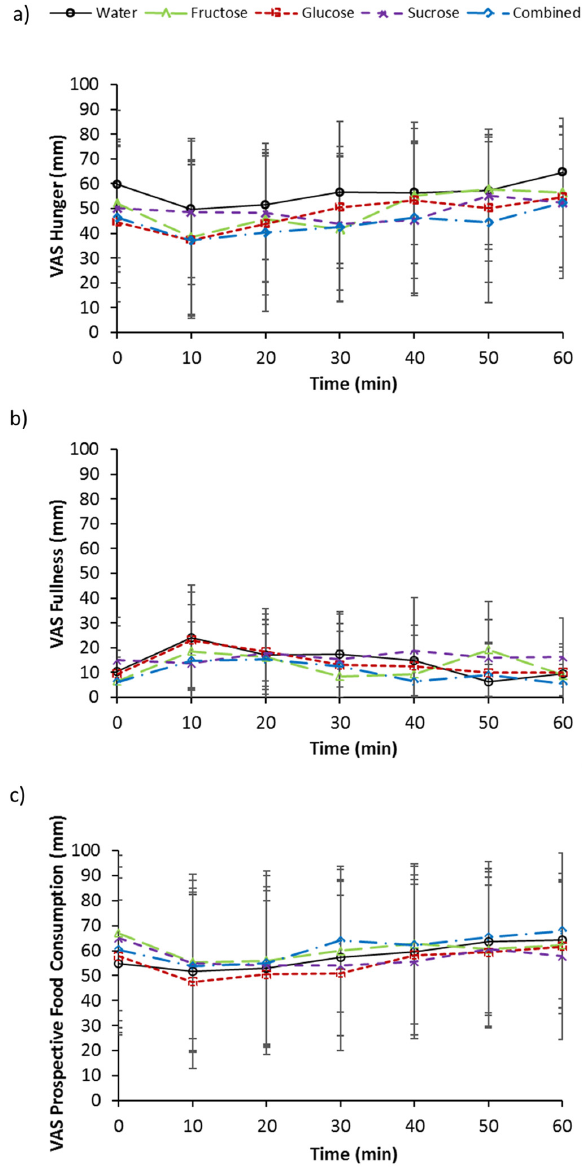
Figure 4. Visual analogue scale (VAS) scores for ( a ) hunger ( b ) fullness and ( c ) prospective food consumption at baseline and following ingestion of 595 mL of water (W), 6% fructose (F), 6% glucose (G), 6% sucrose (S) and 6% combined glucose and fructose (C) solutions. Values are mean ± standard deviation.